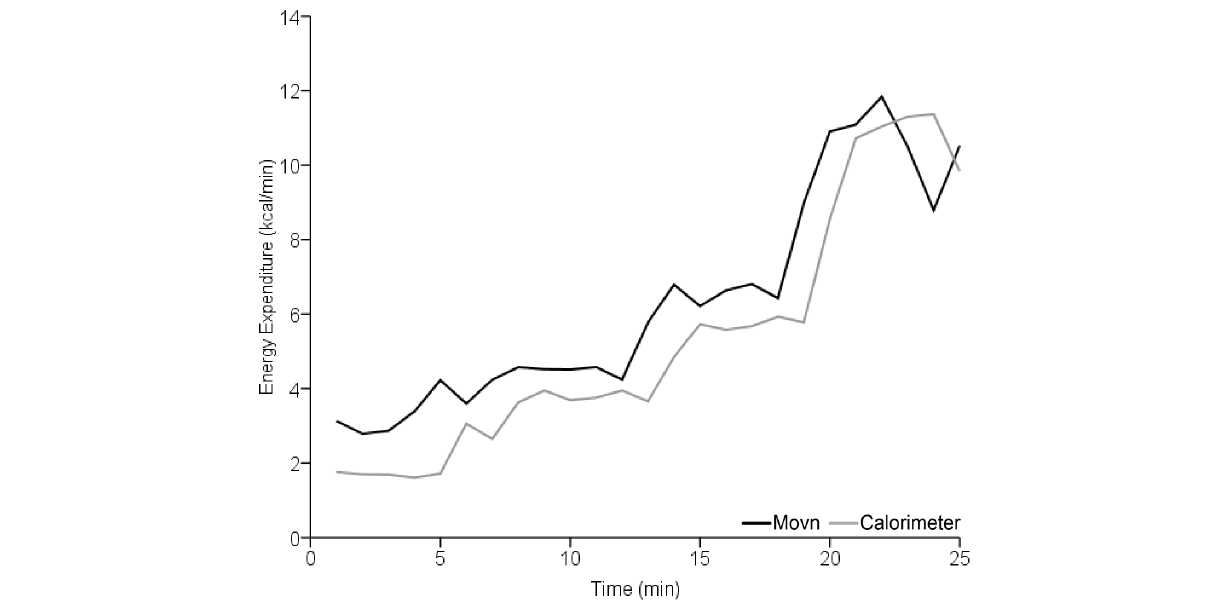
Figure 4. Supplementary analysis of the relative accuracy of measured (indirect calorimetry) and estimated (Movn app) energy expenditure (EE) during